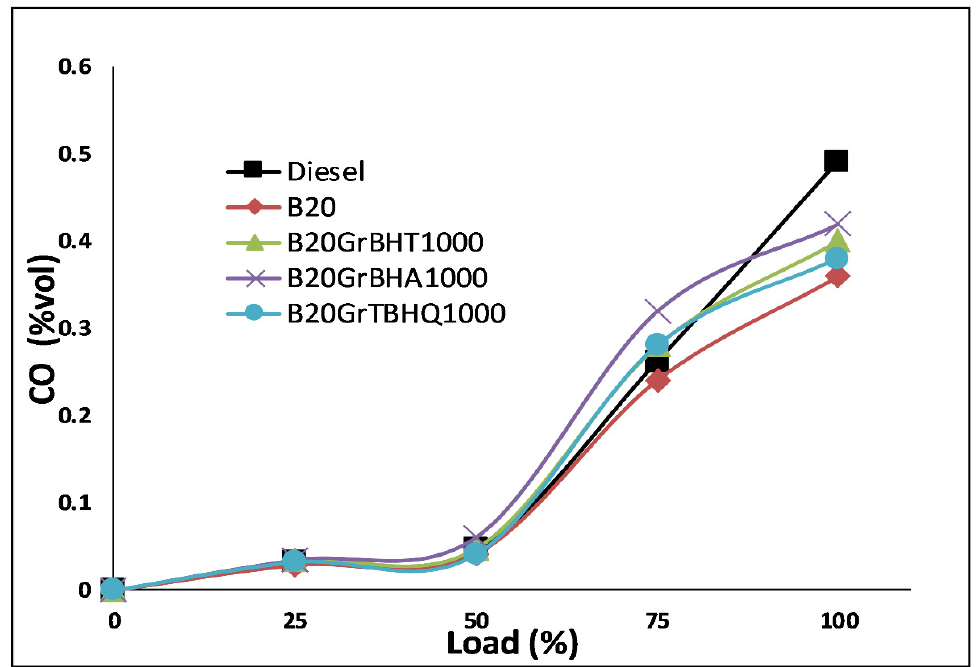
Figure 9. Deviation of carbon monoxide emission with loading.